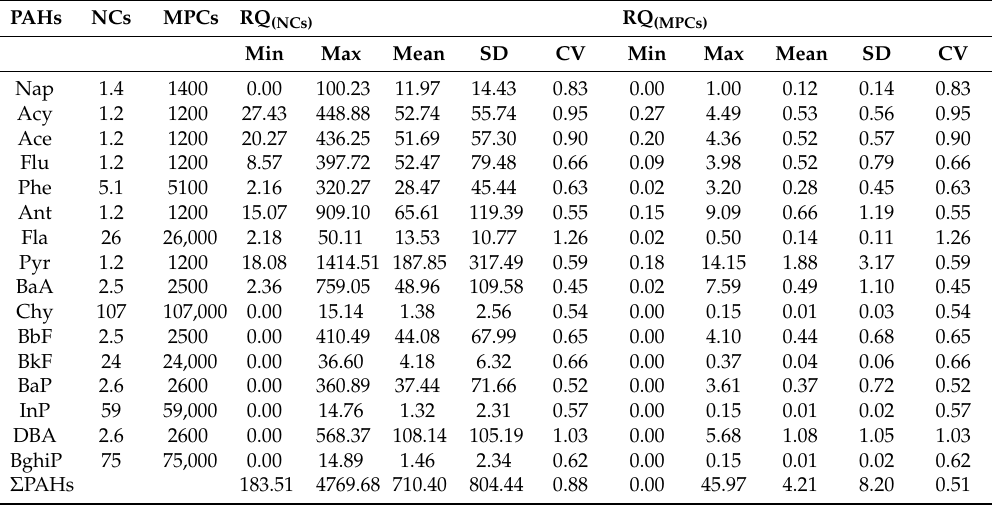
Table 5. Descriptive statistics of RQ (NCs) and RQ (MPCs) of PAHs in urban soil ( µ g/kg).